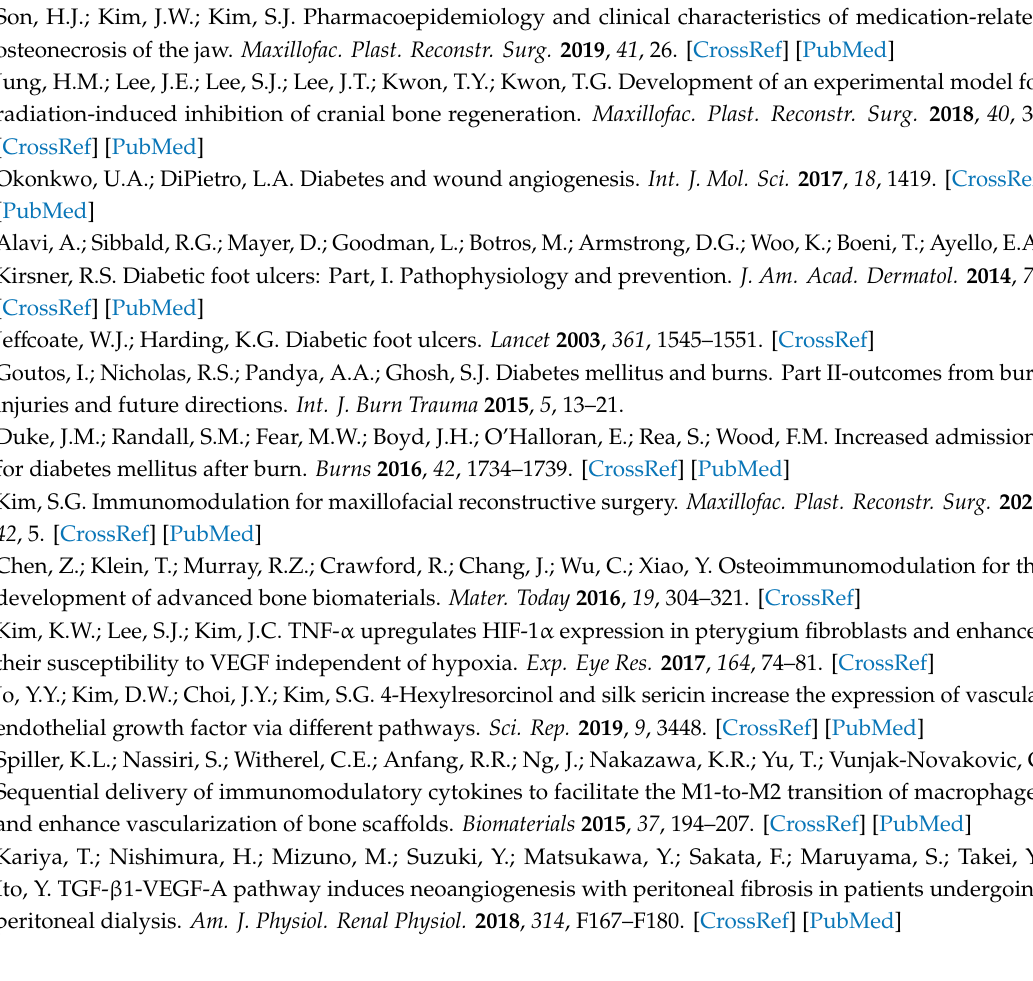
Figure S1. Full-length blot of Figure 1A. Figure S2. Full-length blot of Figure 1B. Figure S3. Full-length blot of Figure 2A. Figure S4. Full-length blot of Figure 2B. Figure S5. The images for burn wound at di ff erent time point. Figure S6. Full-length blot of Figure 5. Figure S7. Determination of optimal concentration of TGF- β 1 siRNA. Figure S8. CORT chart for the animal